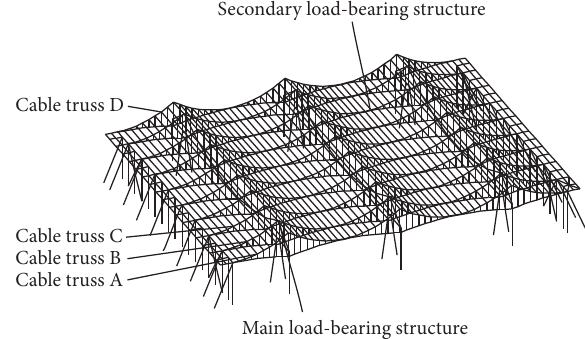
Figure 2: Axonometric drawing of the SCTC.